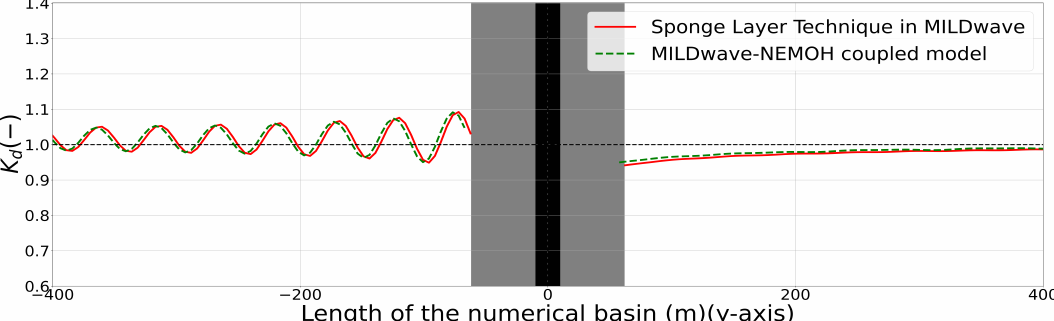
Figure 4. Kd disturbance coefficient results for the MILDwave-NEMOH coupled model and the MILDwave sponge layer technique along one longitudinal cross-section at the centre of the domain for a single HPA WEC interacting with regular waves of H = 2 m and T = 8 s. The coupling region is filled in grey colour and includes the WEC’s cross-section indicated by a black vertical area. Incident waves are generated from the left to the